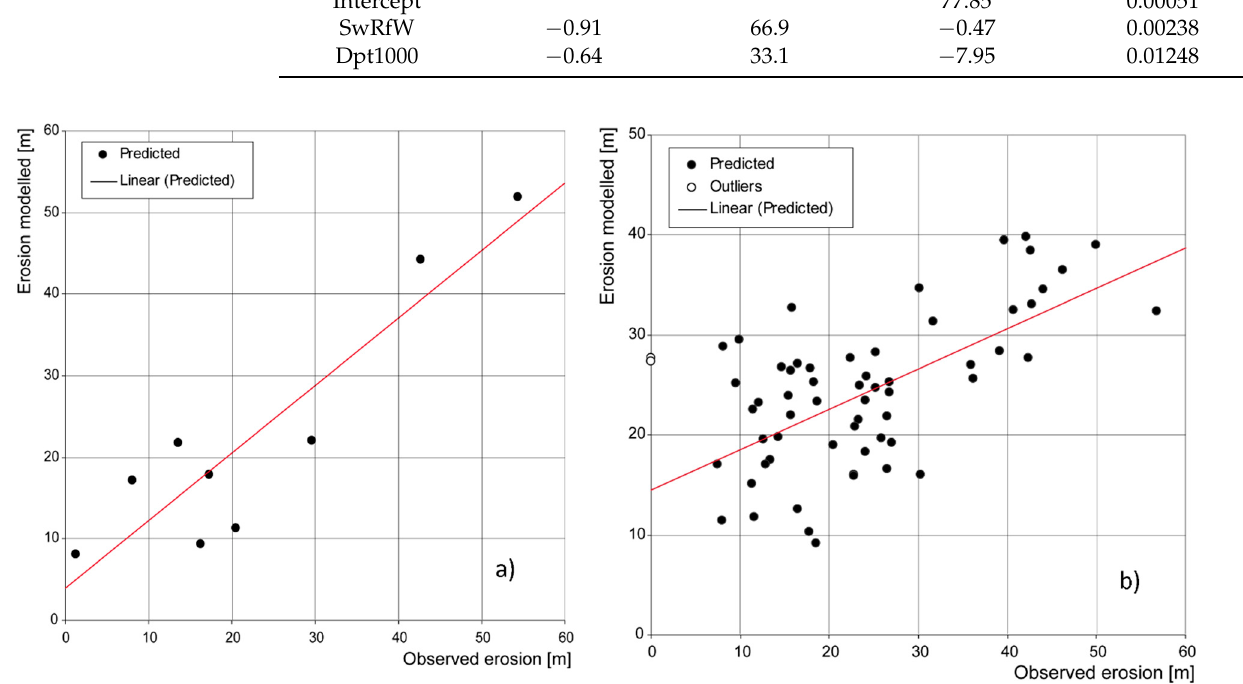
Figure 3. Modelled versus observed erosion for ( a ) areas behind coral reefs and protection and ( b ) areas behind seagrasses (and with coral reef protection).